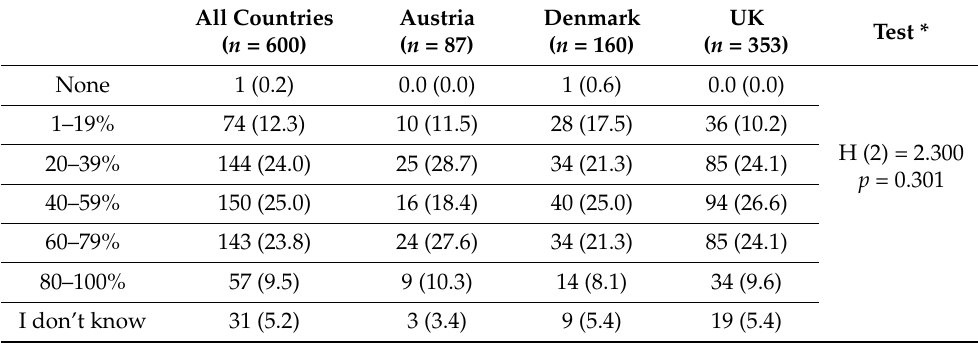
Table 1. Veterinarians’ estimates of clients’ use of internet resources to obtain medical information prior to consultation for the whole study population and by